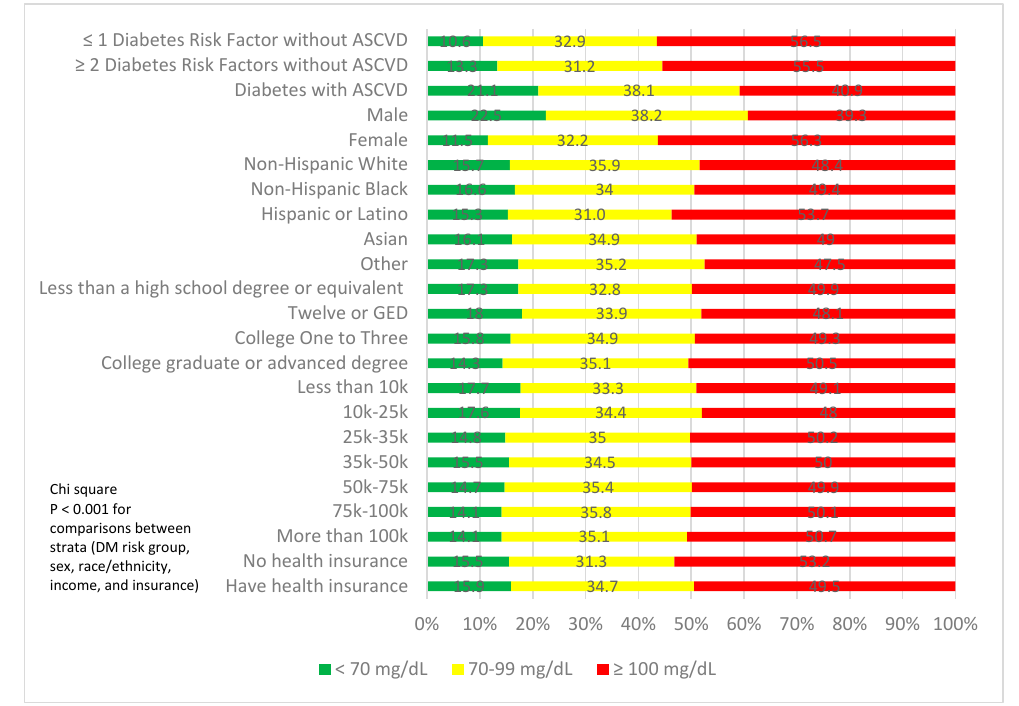
Figure 1. Proportion of subjects at ideal, borderline, or poor LDL-C control by ASCVD risk group, sex, ethnicity, education, income, and health insurance. p < 0.001 across risk, sex, ethnicity, education, income, and health insurance status categories.